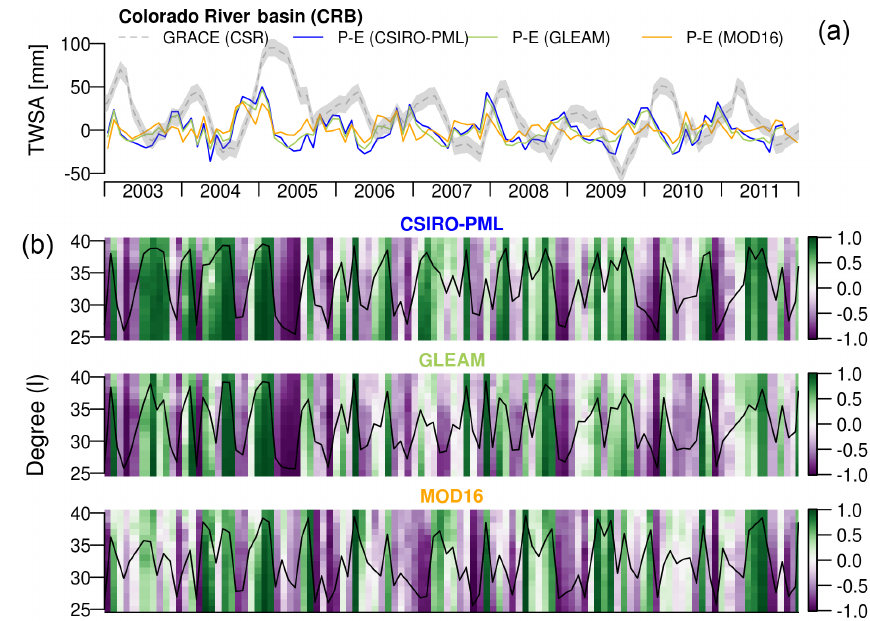
Figure 4. Top: anomalies of the terrestrial water storage (TWSA) observed by GRACE (with 20mm uncertainty bounds) and P − E using three global evaporation products over the Colorado River basin. Below: varying degree correlation measure ( r l ) with time and degree (from 25 to 40) using the three global evaporation products. The average r l is shown as a time series (black line). The degree correlation measure can range from − 1 to 1 as shown in the colour scale on the secondary